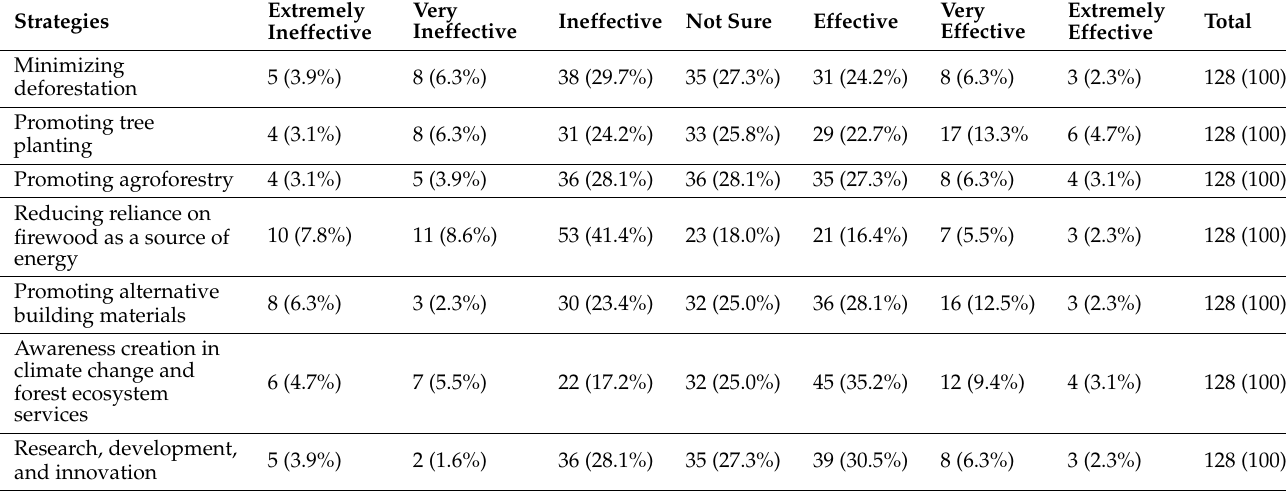
Table A5. Implementation strategies.